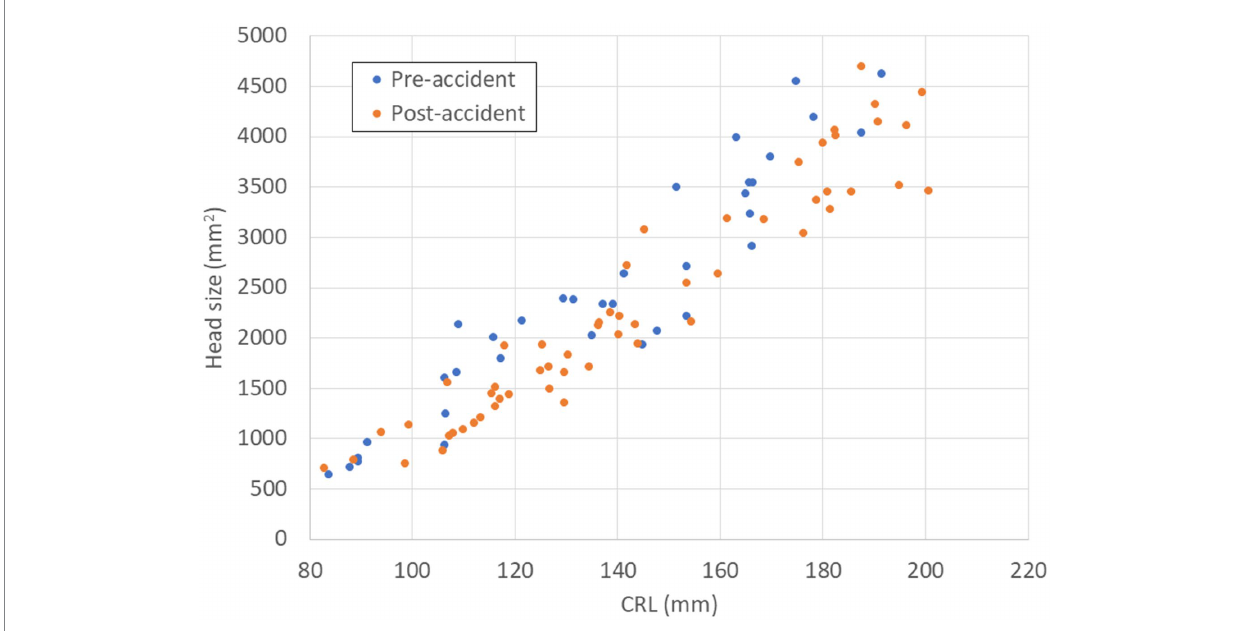
FIGURE 3 Relationship between CRL (mm) and FHS (mm 2 ) in fetal Japanese monkeys before and after the Fukushima Daiichi nuclear power plant accident. Blue circles indicate fetal monkeys before the accident; red circles indicate fetal monkeys after the accident. CRL, crown–rump length; FHS, fetal head